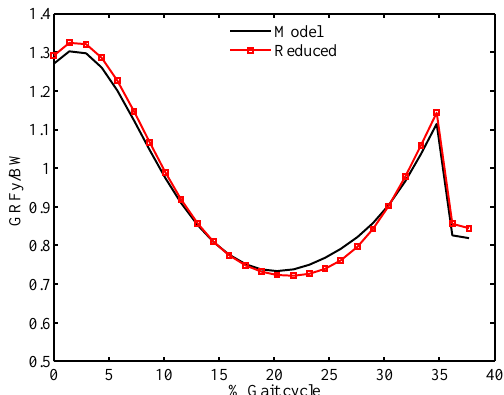
Figure 12. GRFy results when all the DOFs are used and with minimal DOFs in the model with AFROS. The results for the model using FROS are similar. (Gait cycle starts at toe-off of the other leg, that is, at the beginning of